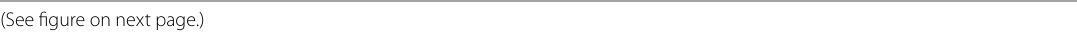
Fig. 2 The angiogenic switch does not depend on hypoxia or Hif-1α . a Imaging of B16 cells incubated with hypoxia probe reagent (oxygen sensor) cultured under hypoxic or normoxia. Scale bar, 100 μm. b Imaging of the hypoxia probe reagent incubated transplant B16 microtumors under normoxia. Tumor is grey. Scale bar, 50 μm. c The length of the first vessel of the B16 microtumors under normoxia. d RT-qPCR quantification of the Hif1α expression in B16-Red cells transfected with Hif1α siRNA (50 μM) for 48 h ( n 3). NC, negative control. e Imaging of the first tumor = vessel growth of Hif1α knockdown B16-Red transplant microtumors. Tumor is red. Scale bar, 50 μm. f The length of the first tumor vessel of Hif1α knockdown B16-Red transplant microtumors. g and h . RT-qPCR quantification of the Car9/CA9 and Slc2a1/GLUT1 expression in the transplant microtumors during the angiogenic switch (about 12 h and 24 h). Red fluorescence, hypoxia. ECs are green. Unpaired t-test, ns P > 0.05, *** P <